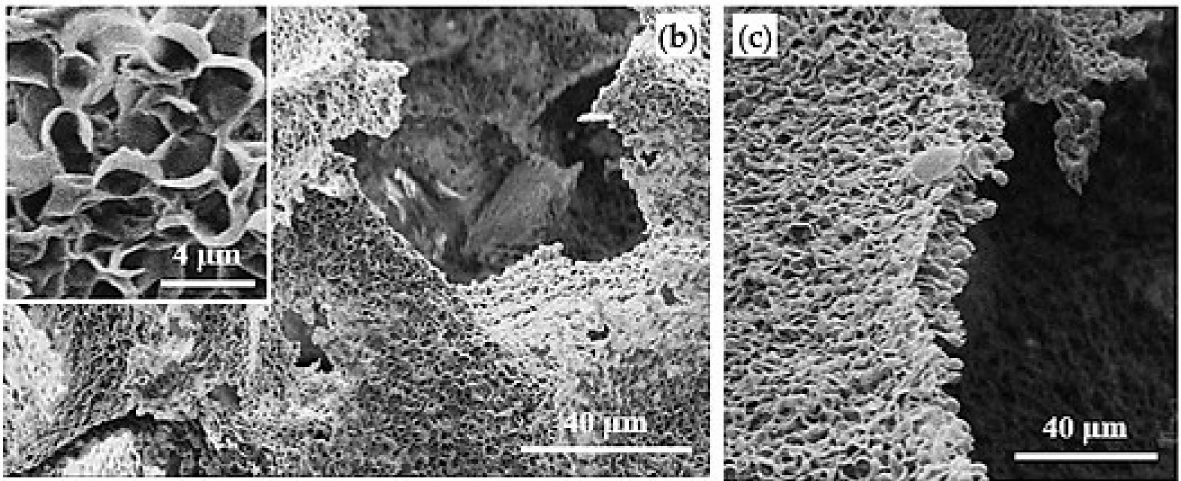
Figure 14. SEM micrograph of the PBS/poly(PA-LO) scaffold prepared using different cooling baths at: − 74 ◦ C ( a ), − 20 ◦ C ( b , c ). Inset shows the leafy structure of the corresponding scaffold at higher magnification.